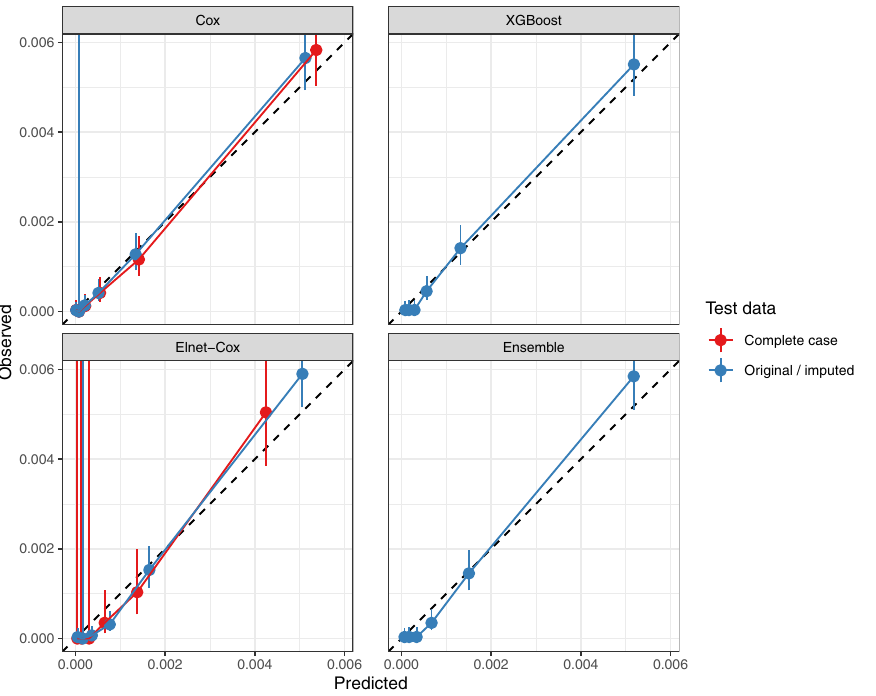
Fig. 3 Calibration plot of IHD models Calibration plot showning observed vs. predicted risk of the model. Observations were divided into groups of roughly same size based on the risk score (linear predictor) computed from the model. The observed risk and its 95% con fi dence intervals were computed from the Poisson GLM.